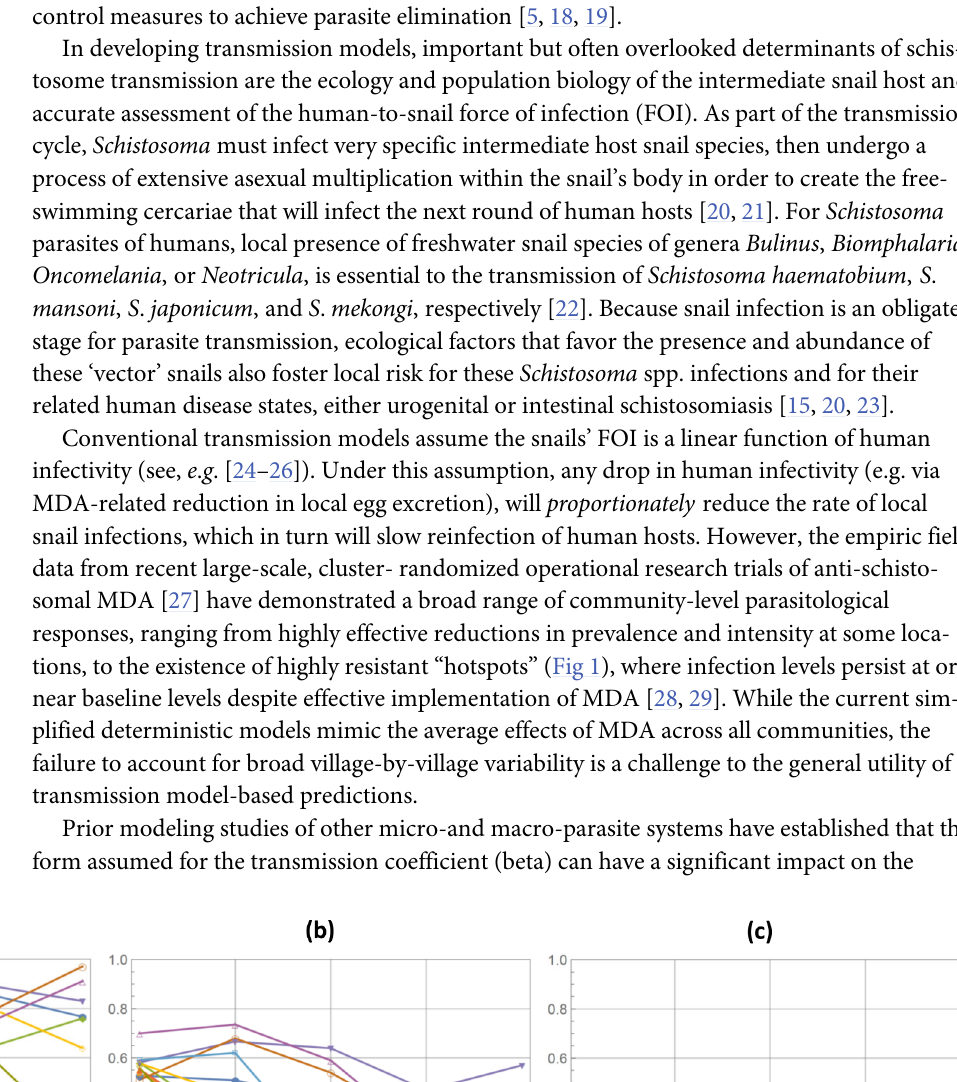
PLOS NeglectedTropical Diseases | https://doi.org/10.1371/journal.pntd.0006514 May 21,